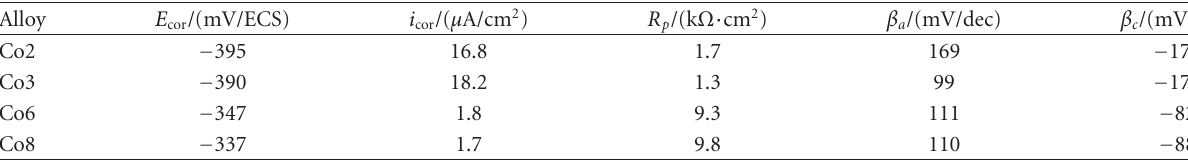
Table 2: Electrochemical parameters of FeCoC ternary alloys corrosion (immersed in 10 − 3 M NaHCO 3 + 10 − 3 M Na 2 SO 4 , at 25 ◦ C). Alloy